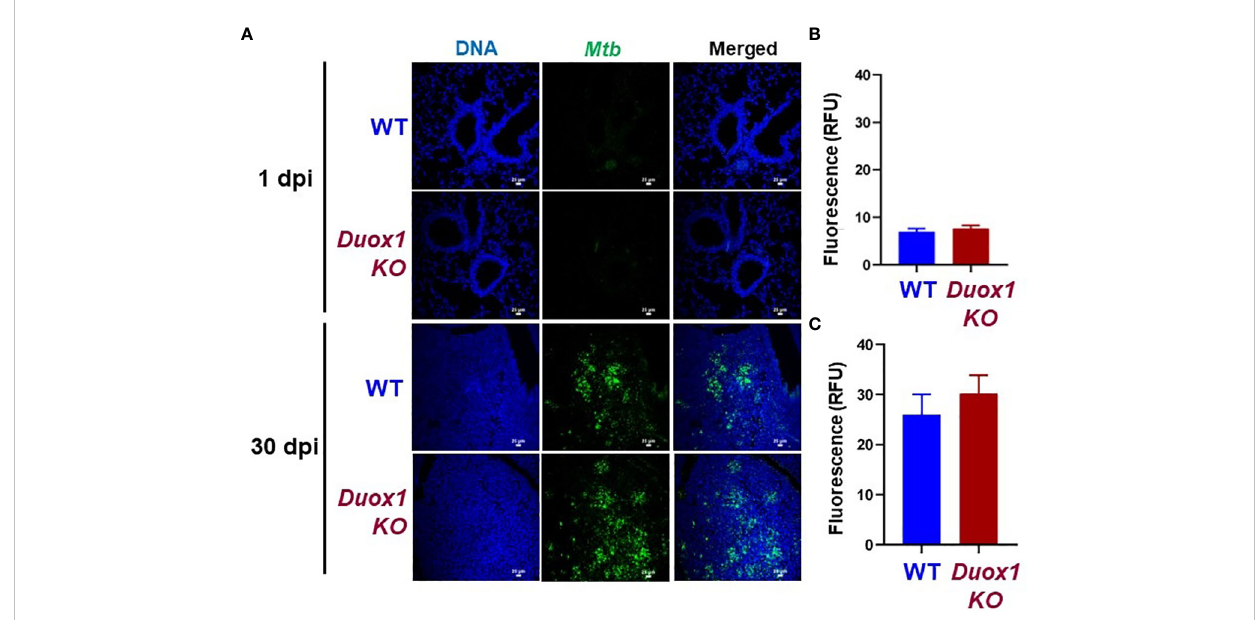
FIGURE 2 Duox1 does not affect Mtb proliferation in the lung. Lungs from Mtb -infected Duox1 KO and WT mice were harvested at 1 and 30 day(s) post- infection, respectively. Fixed and processed lung tissues were stained with primary anti- Mtb antibody followed by a secondary AF488 antibody. (A) Representative fl uorescent images of six similar results are shown. White scale bars indicate 25 m m. Mean green fl uorescent intensities (MFI) indicative of Mtb burden were quanti fi ed for (B) 1 day post-infection and (C) 30 days post-infection in Duox1 KO (n=6) and WT mice (n=6). Error bars represent ± SEM. Mann Whitney U-test. Duox1 KO: Duox1 -de fi cient; WT, wild-type; RFU, relative fl uorescence